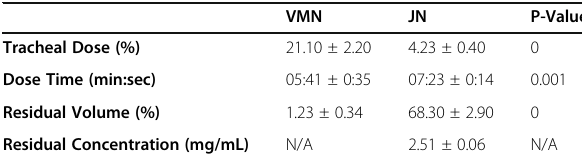
Table 1 (abstract A187). Mean ± SD Nebuliser